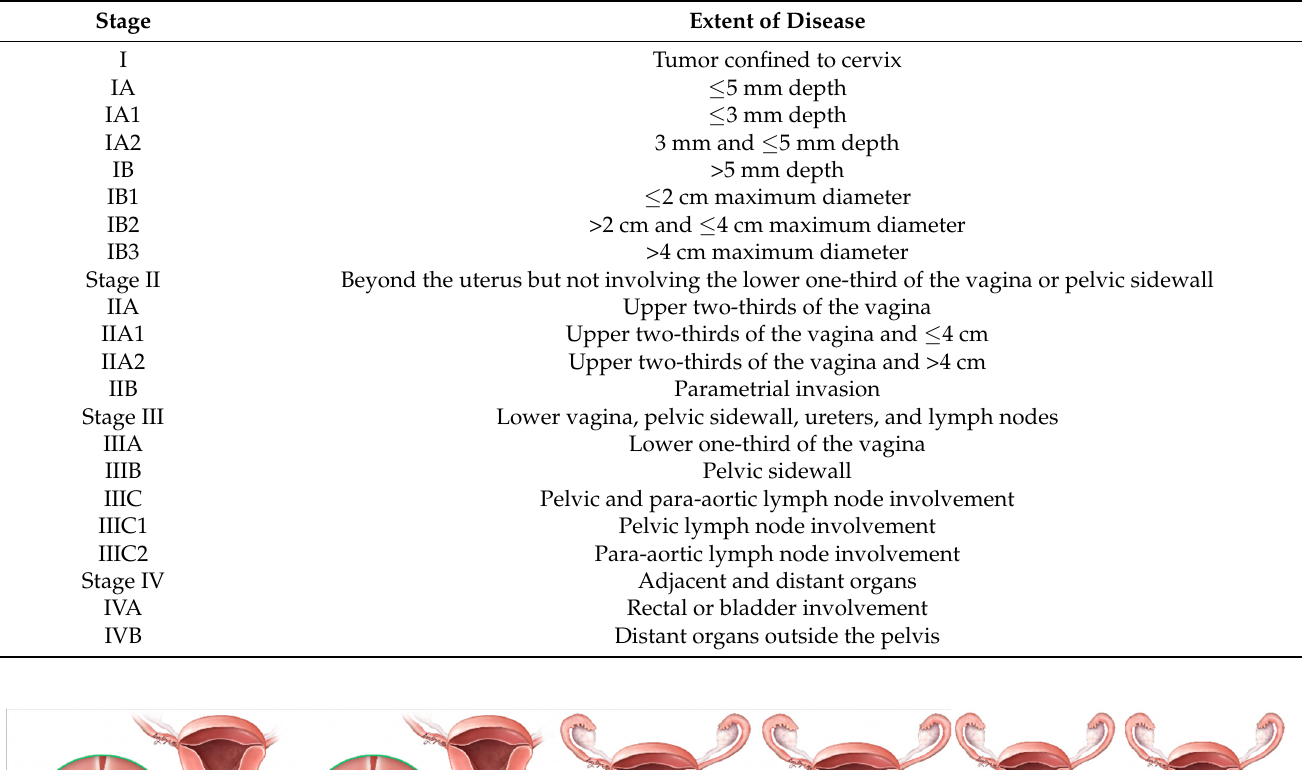
Table 5. FIGO 2018 staging of cervical cancer.